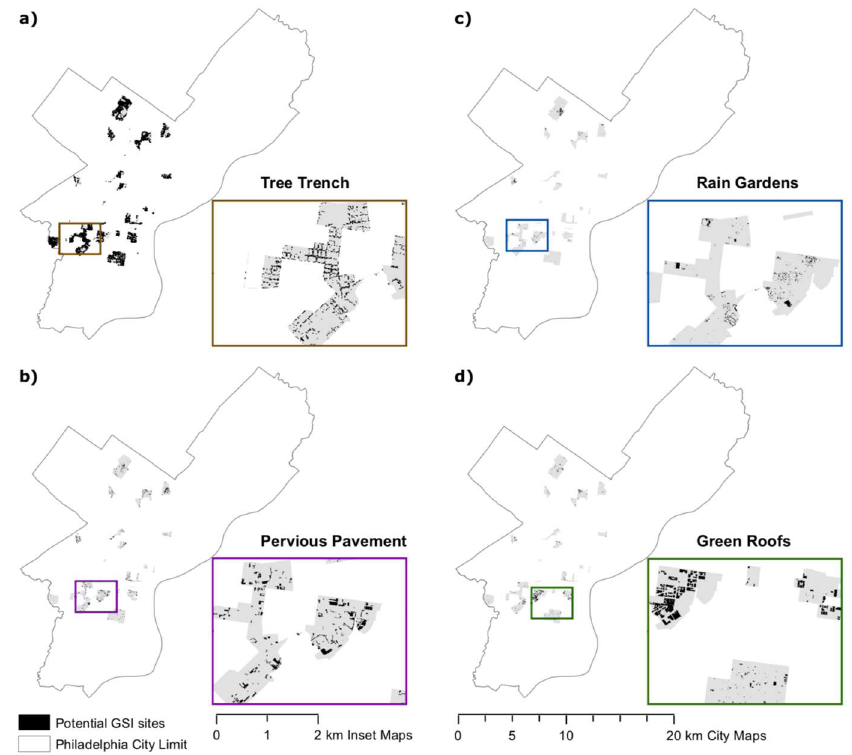
Figure 1. The distribution of potential GSI implementation sites by type of feature, across the City of Philadelphia.